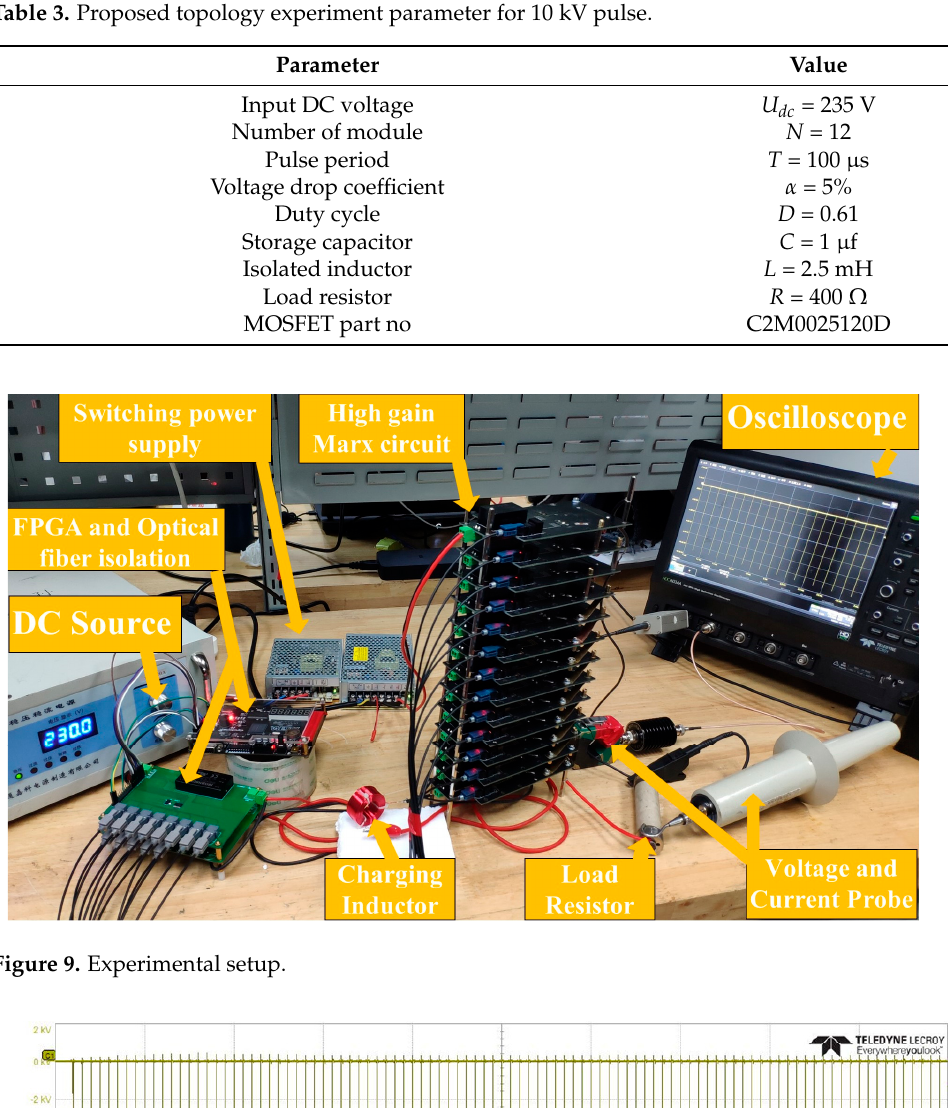
Figure 10. Output voltage dynamic response during starting.